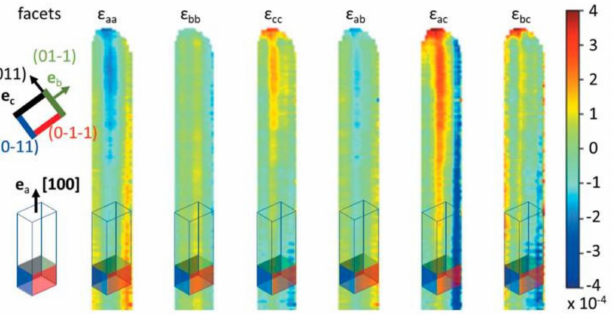
Figure 11. Mapping of the components of the strain tensor expressed in a base (a, b, c) whose vectors are aligned with the facets of the VO 2 microwire. Facets perpendicular to the c, b,-c, and -b directions are colored black, green, red, and blue, respectively. This orientation is superimposed on the maps to guide the reader [112]. Reproduced from [112] with the permission of the International Union of